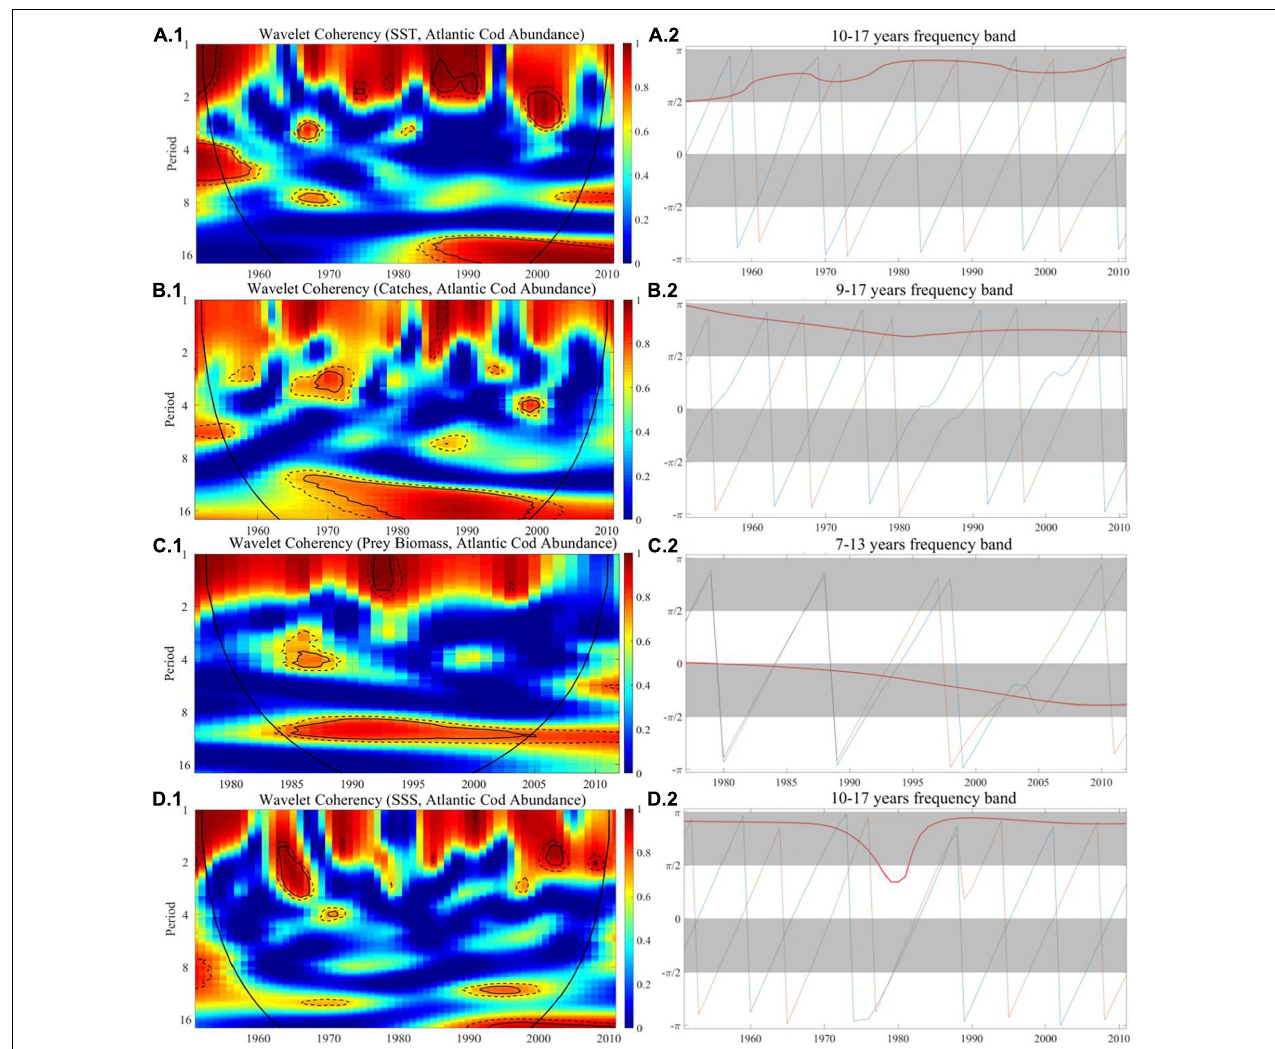
FIGURE 7 | The wavelet coherence and phase difference between Atlantic cod abundance and SST, catches, prey biomass, and SSS at site 428. (A–D.1) Wavelet coherence and (A–D.2) phase difference. The y -axis refers to frequency (in years), and the x -axis refers to the time period.